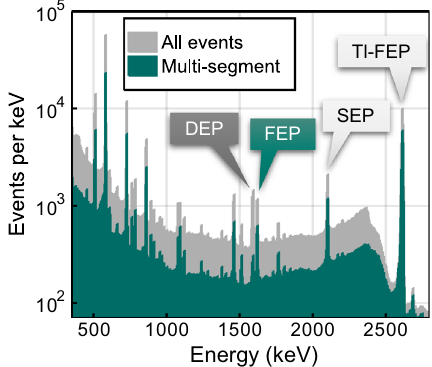
Fig. 2 Calibrated energy spectrum from the 228 Th source, recon- structed from the core electrode signals. The gray spectrum shows all events. The green spectrum shows only those events with energy depo- sitions in multiple segments of the detector. The 208 Tl double-escape peak (DEP 1593 keV), the 212 Bi full-energy peak (FEP 1621 keV), the 208 Tl single-escape peak (SEP 2104 keV) and the 208 Tl full-energy peak (Tl-FEP 2615 keV) are marked. Events from the DEP and FEP are used as examples of signal and background events during training of our classifier, the labels are colored accordingly